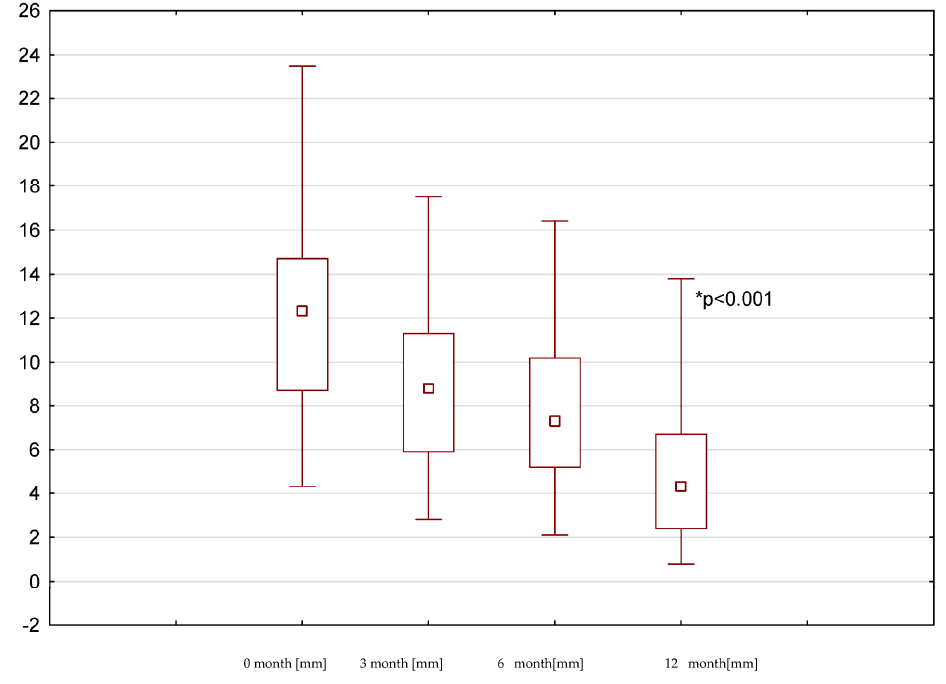
Figure 2. The thickness of the Schneider membrane in mm from 0 to 12 months of the treatment period.